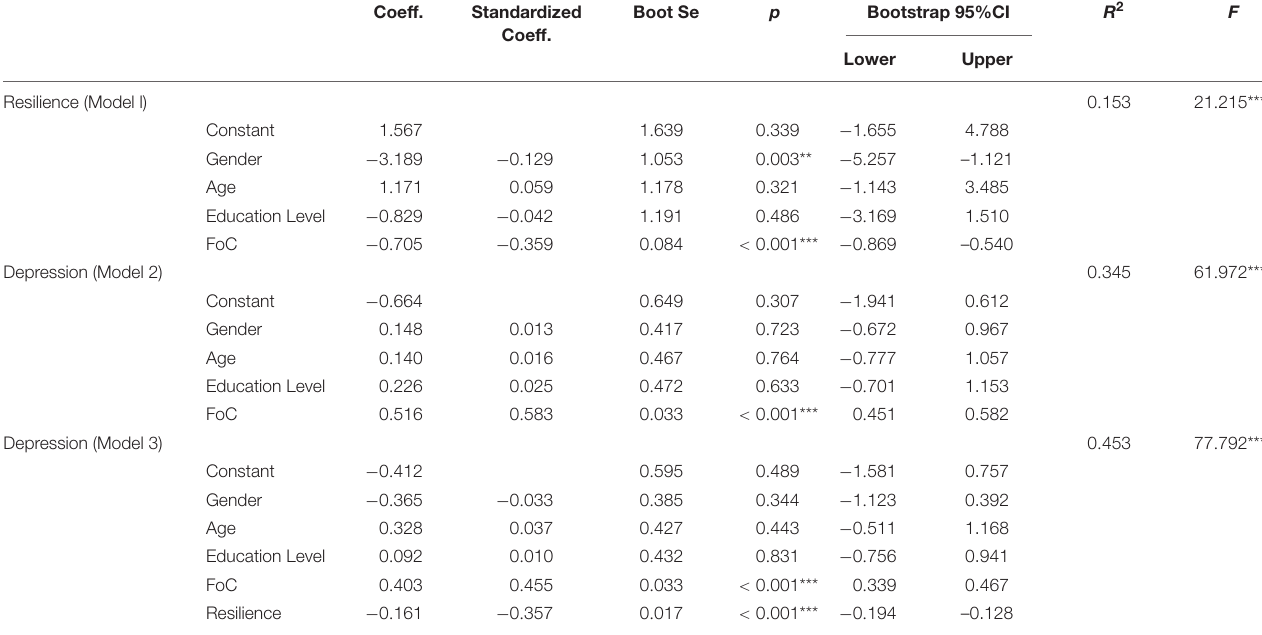
TABLE 3 | Regression analysis of relationship between fear of COVID-19 and depression with mediation analyses ( N = 476). Coeff. Standardized